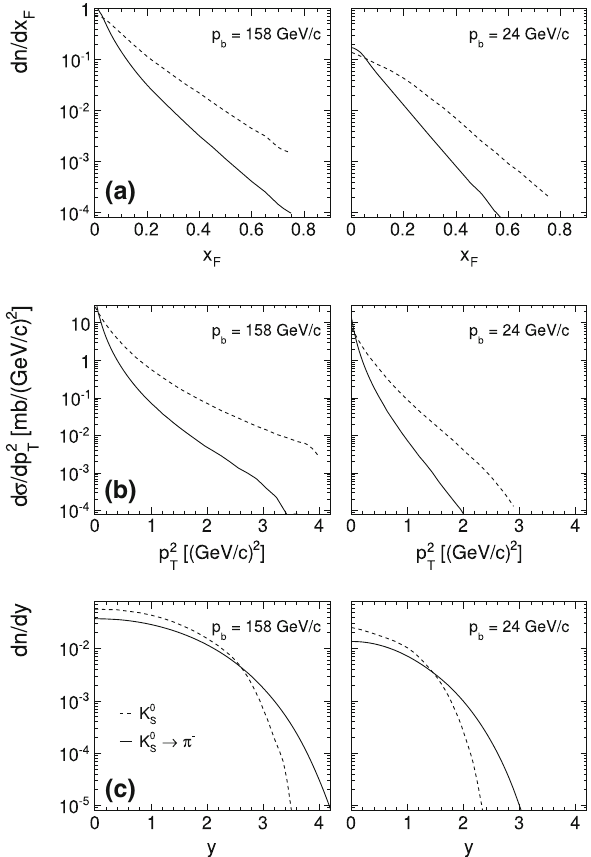
Fig. 15 a dn / dx F as a function of x F , b d σ/ dp 2 and c dn / dy as a function of rapidity for p beam = 158 and 24 GeV/c. The full lines correspond to the π − yields, the broken lines to the parent particle K 0 S